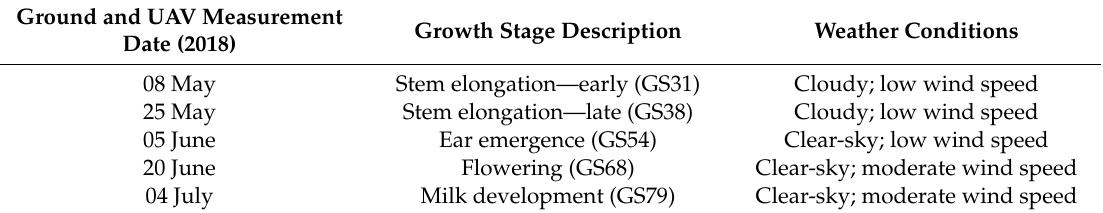
Table 1. Dates, corresponding average growth stages (GS; Zadoks scale) and weather conditions during ground and Unmanned Aerial Vehicle (UAV) multispectral measurement made at the winter wheat trial